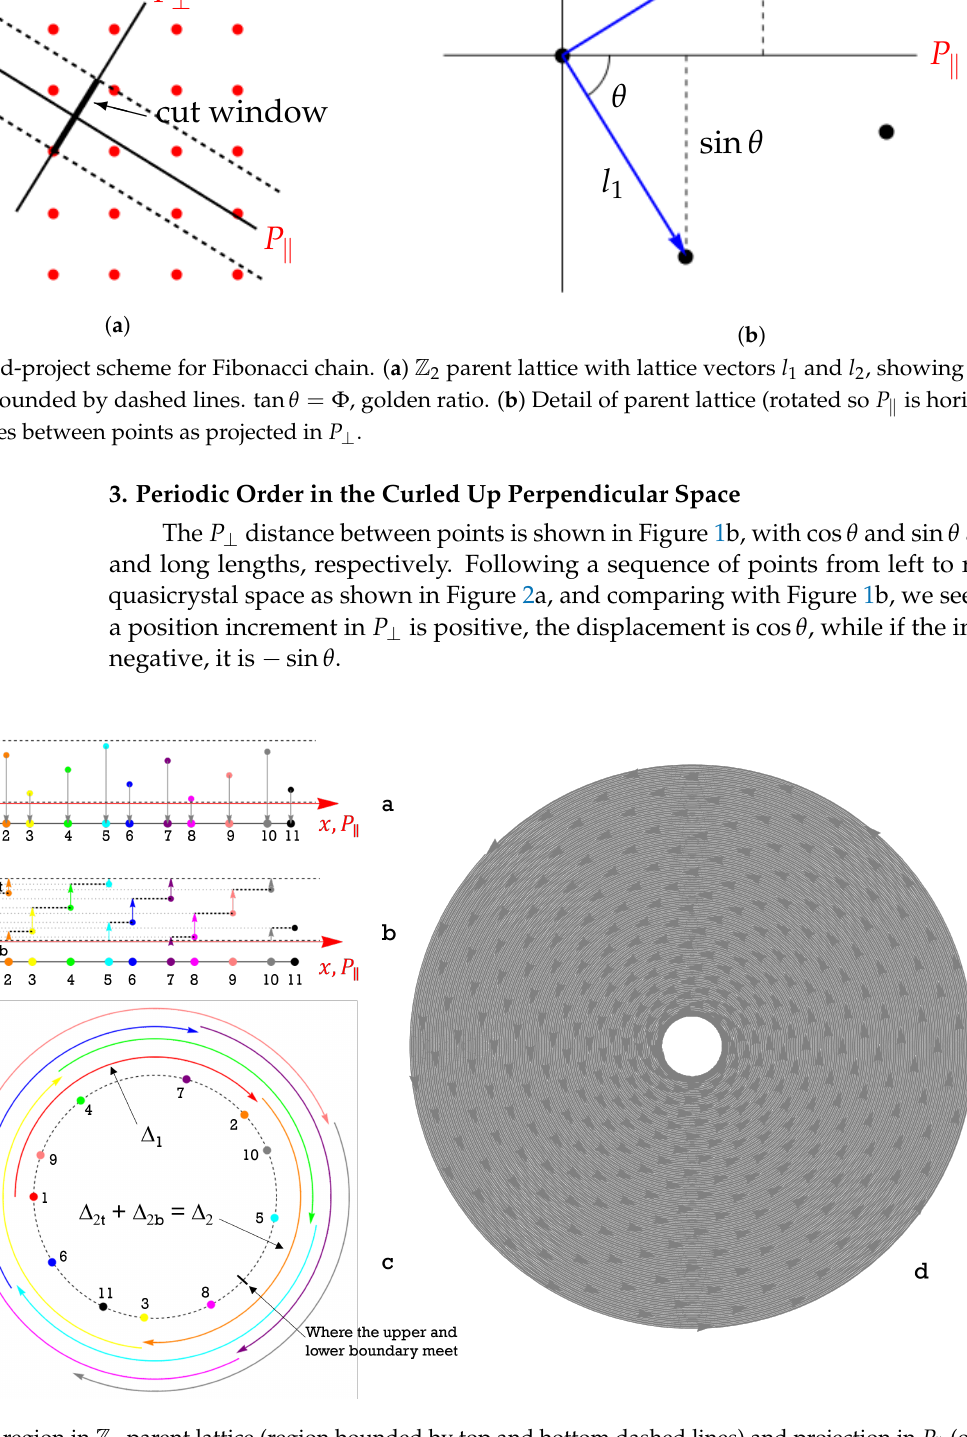
(on solid Figure 2. ( a ) Cut region in Z 2 parent lattice (region bounded by top and bottom dashed lines) and projection in P Figure 2. a. Cut region in Z 2 parent lattice (the region bounded by the top and bottom dashed lines) (cid:107) line). ( b ) Periodicity after identifying top and bottom boundaries of P , showing equal increments in P (examples ∆ 1 , ∆ 2 b , and projection in P (on solid line). b. The periodicity after identifying top and bottom boundaries of ⊥ ⊥ k and ∆ 2 t labeled). ( c ) Same periodicity illustrated after wrapping P into a loop. Dashed circle is P ; colors match points and , showing equal increments in P (examples ∆ 1 , ∆ 2 b , and ∆ 2 t labeled). c. Same periodicity illustrated P ⊥ ⊥ ⊥ ⊥ increments in ( a , b ) with points and arcs in ( c ). ( d ) Displaying the successive arc segments and arrow tips with increasing after wrapping P into a loop. Dashed circle is P ; colors match the points and increments in a and b ⊥ ⊥ radius spreads the circle into an annulus, making the self-similarity of the structure more visually with the points and arcs in c.